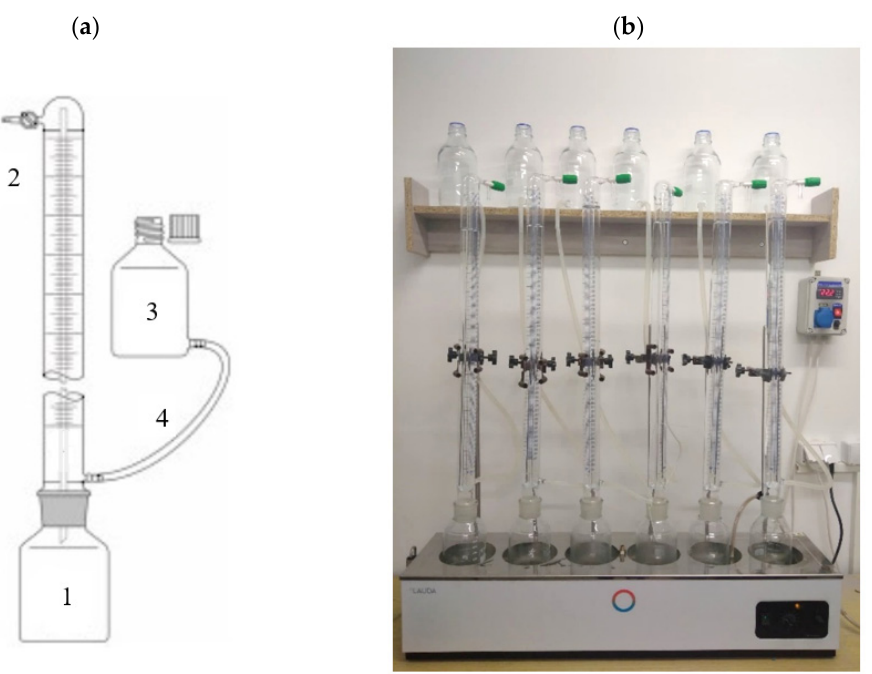
Figure 4. Respirometric measurements: ( a ) scheme of an eudiometer (1—reactor, 2—burette with an internal glass tube for gas transport, 3—pressure equalization tank, 4—connecting tube), ( b ) experimental station photo in S2.